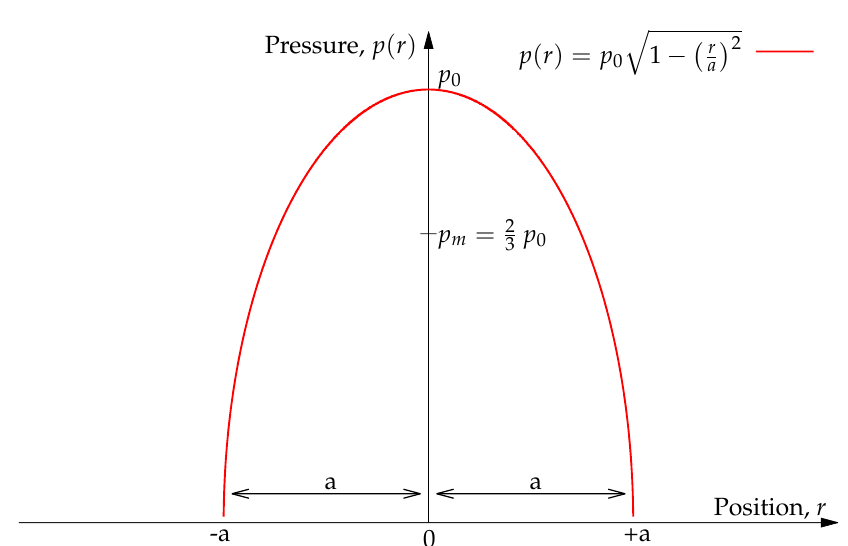
Figure 1. Pressure distribution in Hertzian contact. The maximum pressure is denoted by p 0 , and the mean pressure is denoted by p m . The distribution is centred at zero and spans over the contact’s radius, a . Beyond the contact radius ( r > a ), the distribution is